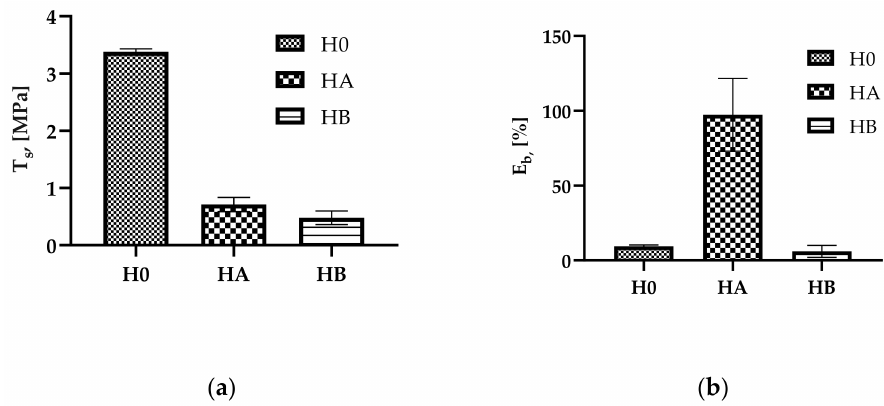
Figure 2. Tensile strength ( a ) and elongation at break ( b ) for H0, HA, and HB.